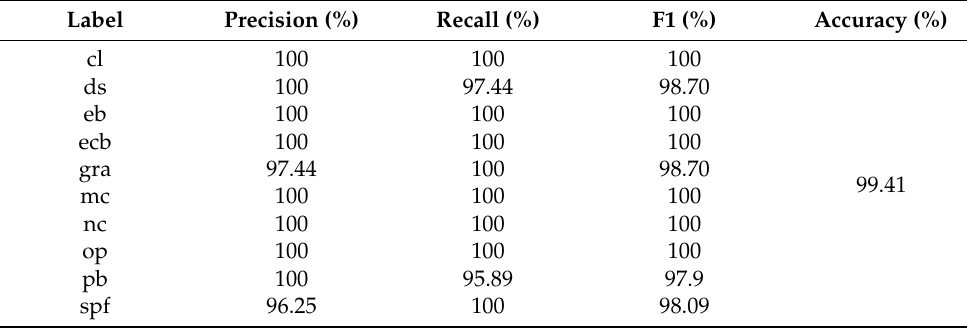
Table 6. Evaluation of classification performance.